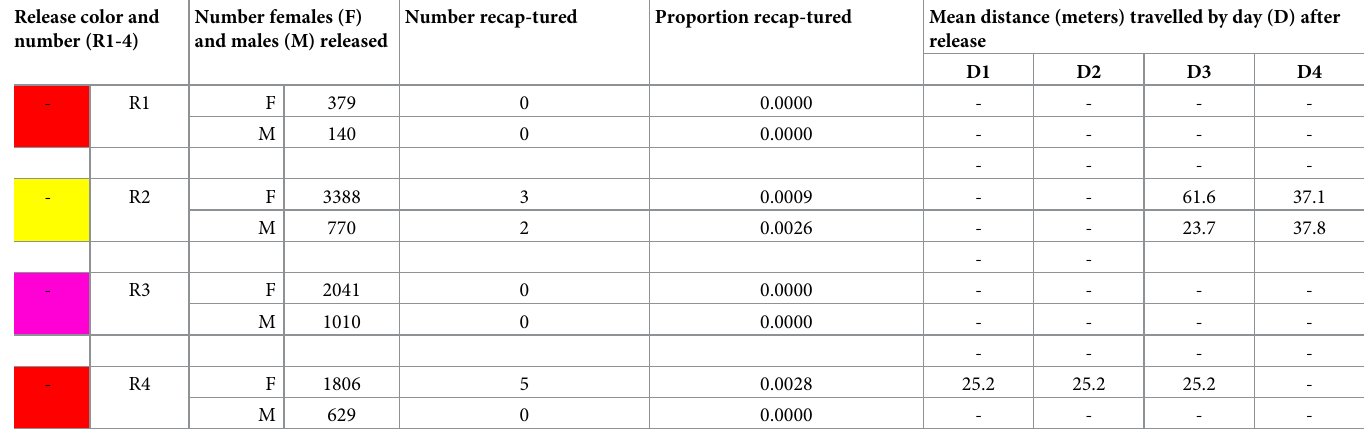
pated for 3 weeks, yielding four weeks of collections from each of 23 houses, one week from the first house that dropped out, and the remaining three weeks from the 25 th house. Release, recapture, and MDT of marked mosquitoes. Table 2 illustrates the recapture rate and mean distance travelled (MDT). A total of 10,163 marked adult mosquitoes (7,614 female, 2,549 male) were released from R1-R4. During the experimental period, a total of ten (0.01%) live, marked mosquitoes were recaptured, with five mosquitoes recaptured from each of two rounds (R2 and R4). Four out of five mosquitoes from R2 were recaptured in the quad- rant south-east of the CRP. Three days after the second release two mosquitoes were recap- tured at similar angles from the CRP. All five mosquitoes from the last release (R4) were recaptured within the same house, located south-west of the CRP. The MDT was 34.8m, and the furthest recapture point from the CRP was 85.4m; nine out of ten mosquitoes (90%) were found within 50m of the CRP. Table 2. MMRR study: Number of Cx . quinquefasciatus mosquitoes released, number and proportion recaptured, and mean distance travelled (MDT), Sı´tio Novo, Olinda, RMR, Brazil, July 22–August 21, 2015. Release color and Number females (F) Number recap-tured Proportion number (R1-4) and males (M) released